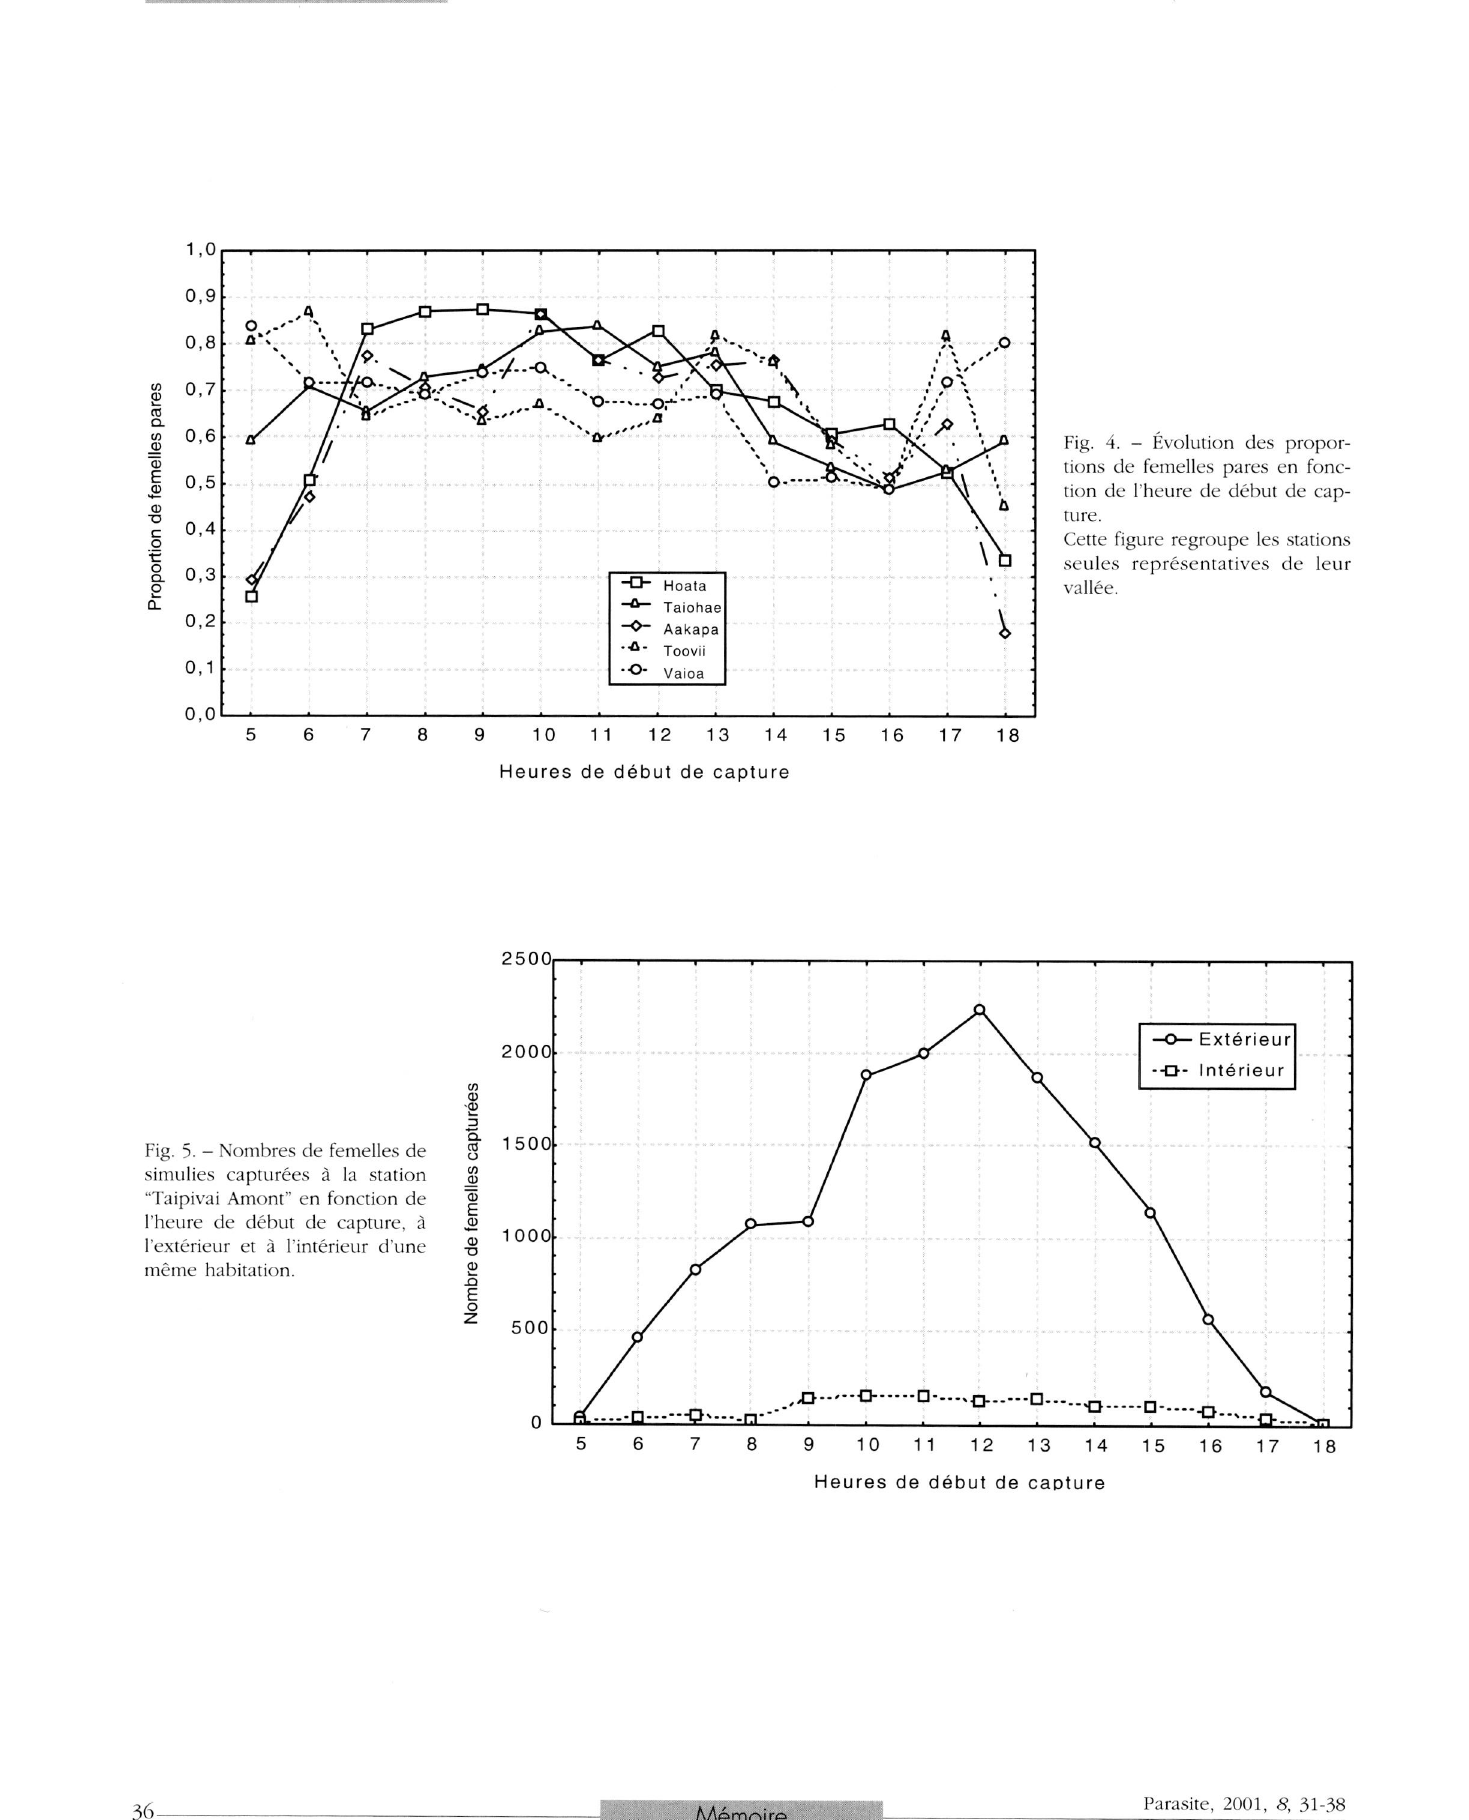
Fig. 4. - Évolution des propor tions de femelles pares en fonc tion de l'heure de début de cap ture. Cette figure regroupe les stations seules représentatives de leur